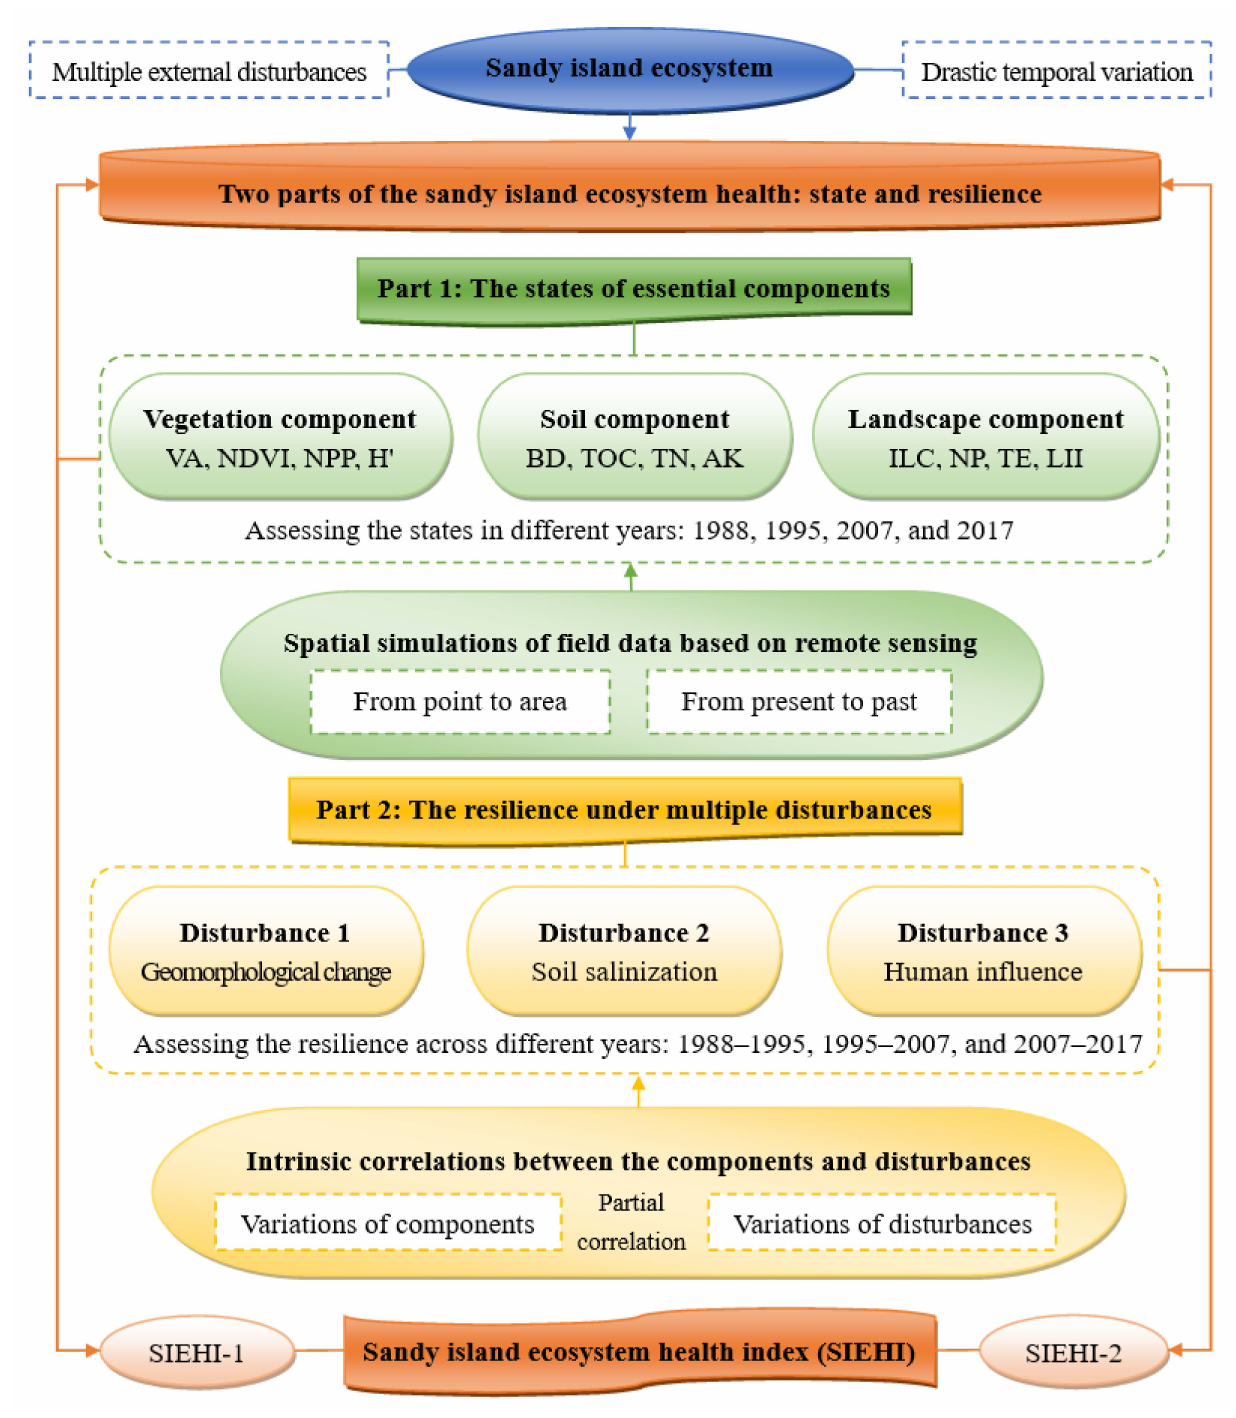
Figure 1. Framework for assessing the sandy island ecosystem health: VA: vegetation abundance (dimensionless); NDVI: normalized difference vegetation index (dimensionless); NPP: net primary productivity (g C m − 2 a − 1 ); H’: Shannon–Wiener index (dimensionless); BD: bulk density (g/cm 3 ); TOC: total organic carbon (g/kg); TN: total nitrogen (g/kg); AK: available potassium (mg/kg); ILC: important landscape coverage (dimensionless); NP: number of patches (dimensionless); TE: total edges (m); LII: landscape isolation index